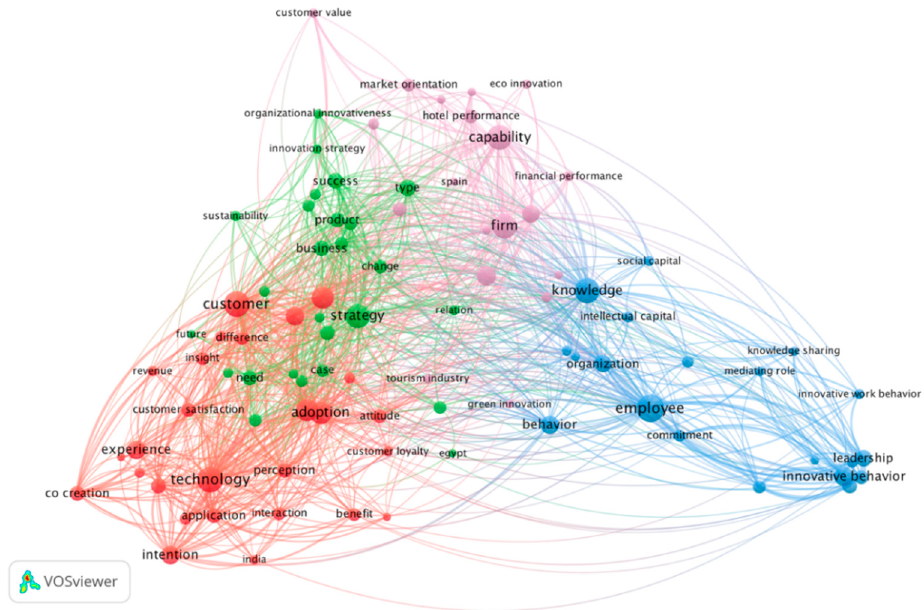
Figure 3. Global thematic network in innovation in hotel research based on word co-occurrence analysis.